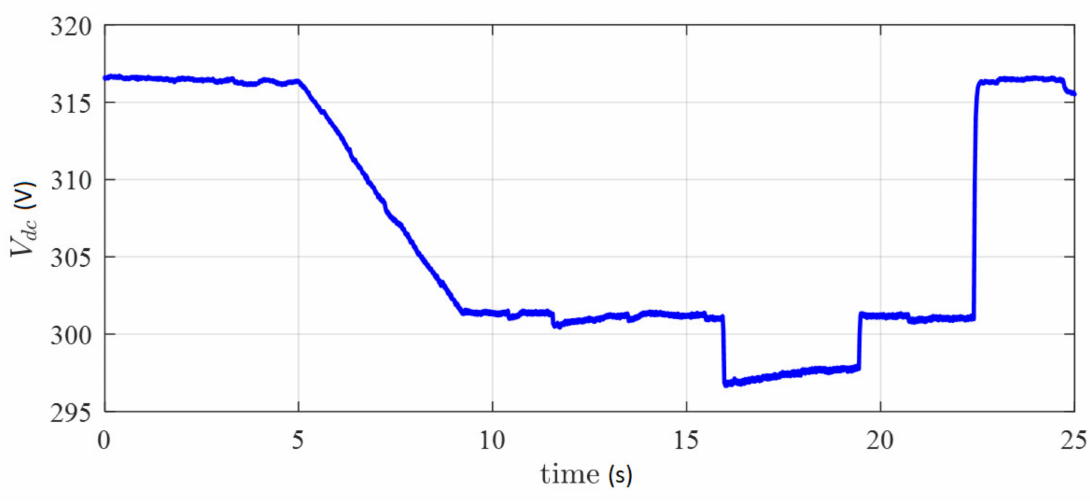
Figure 14. DC voltage across the input DC-side capacitor during the